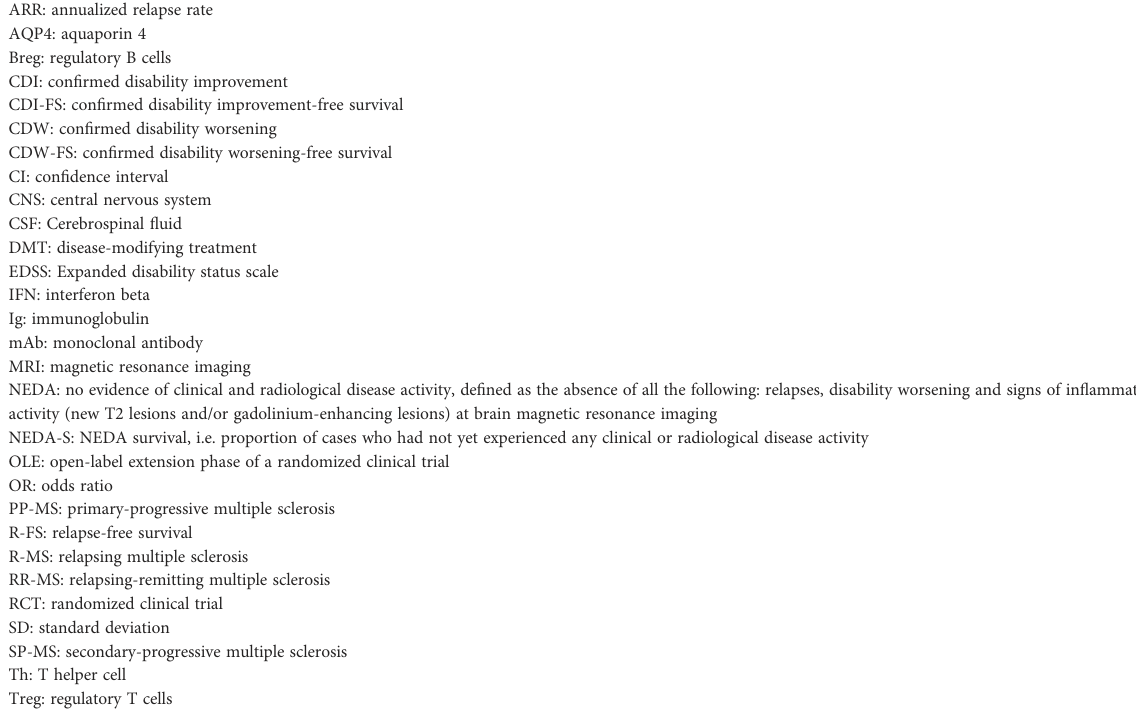
TABLE 1 Abbreviations used in the